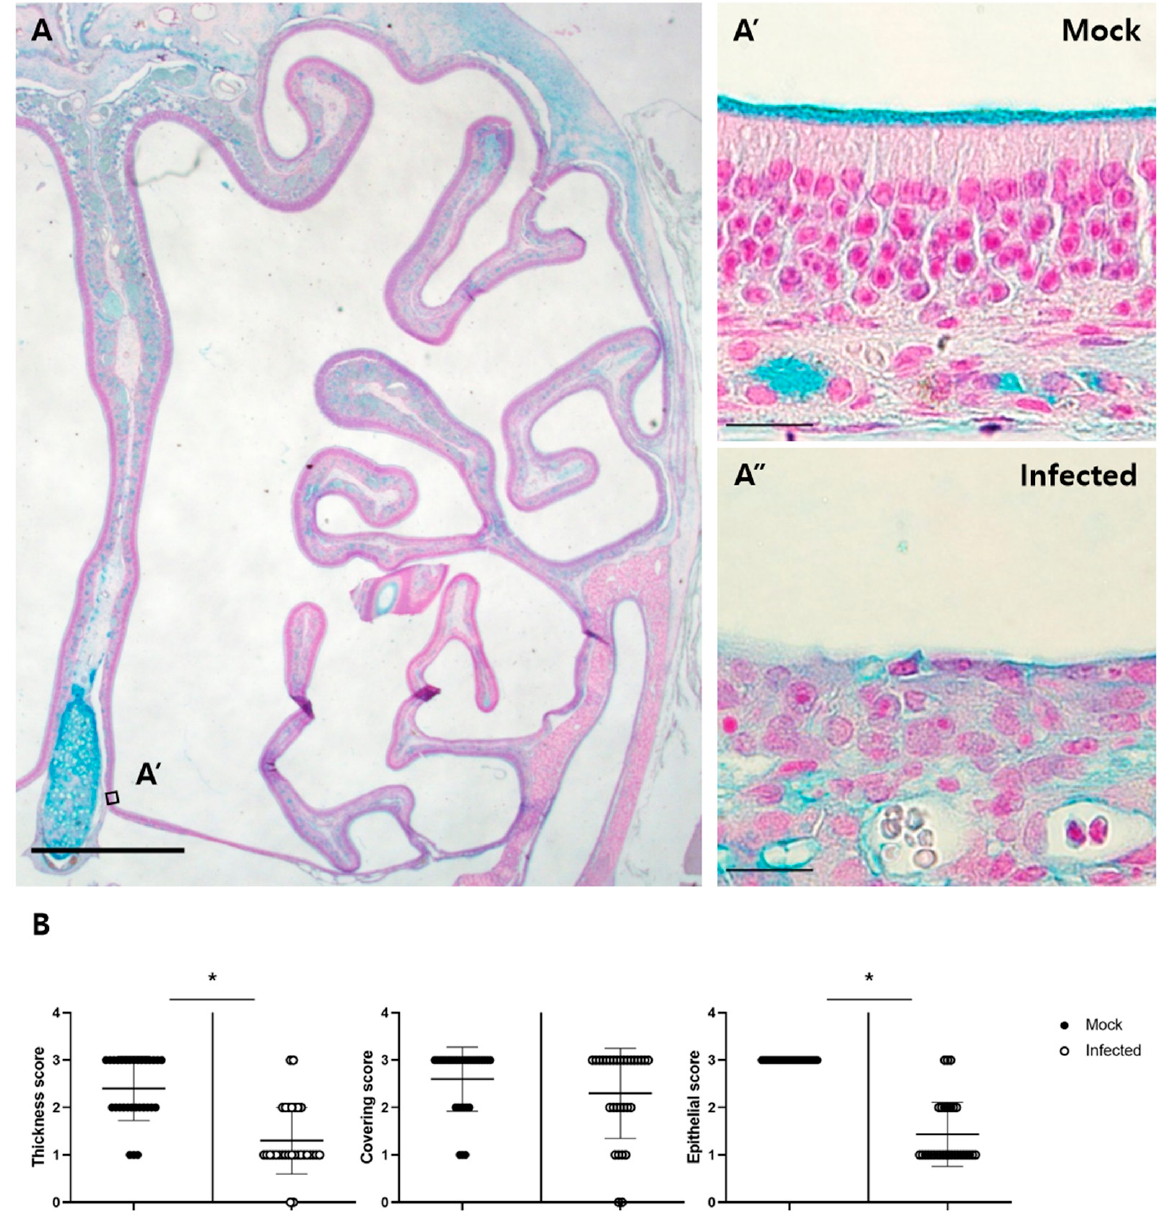
Figure 5. Pathologic changes in the MOE. ( A ) AB-PAS staining in the MOE of the mock group. A’ and A” are representative images cropped from the same region of the mock and infected groups, respectively. Alcian blue-positive mucus materials are seen on the luminal surface of the MOE and Bowman’s glands. The scale bar in ( A ) is 1 mm, and the scale bars in the cropped images are 20 µ m; ( B ) histopathological scoring of thickness, mucus covering, and epithelial damage. The scores for mucus thickness and epithelial damage were significantly different between the mock and infected groups (* p < 0.05, Mann–Whitney U test, n =